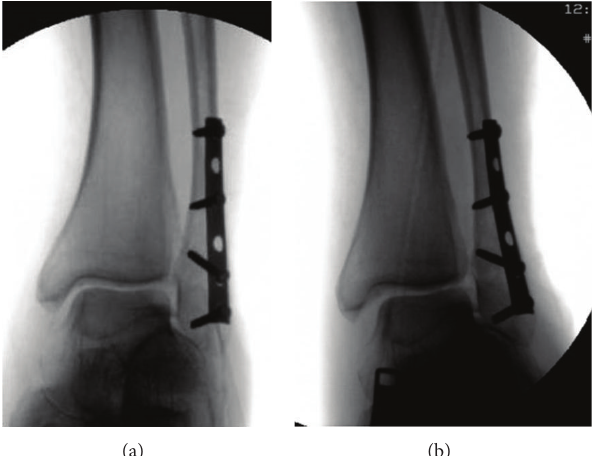
Figure 3: Intraoperative fluoroscopic images of failure case. (a) Preexternal rotation stress mortise view. (b) External rotation stress mortise view. Medial clear space widening suggestive of missed syndesmotic